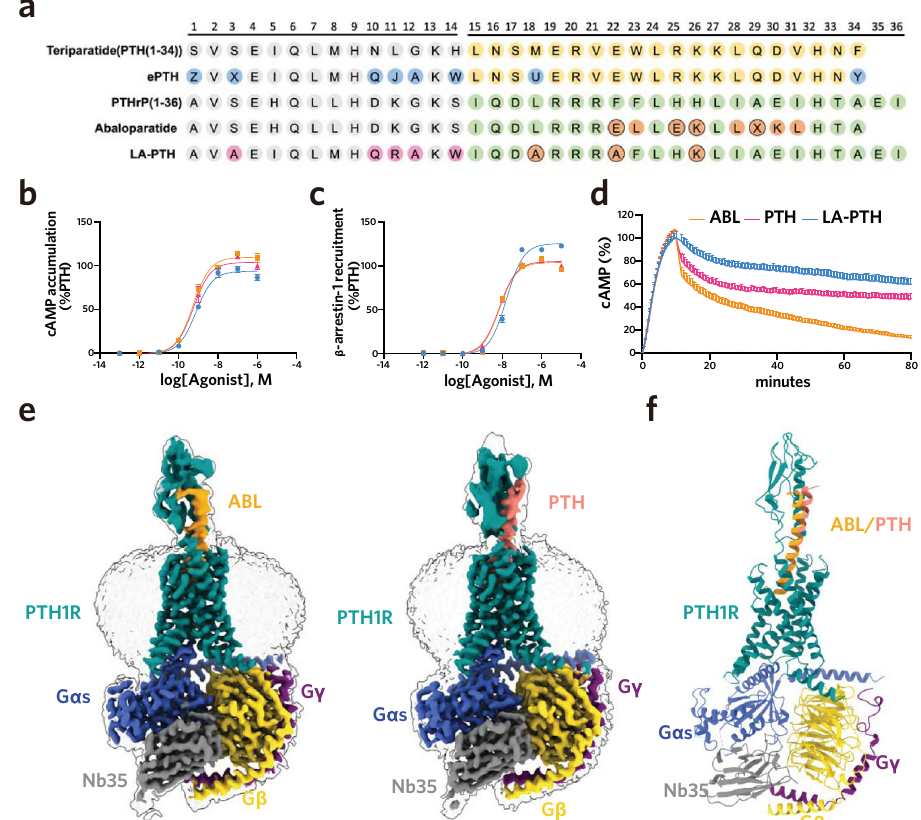
Fig. 1 | Cryo-EM structures of PTH – and ABL – bound PTH1R – Gs complexes. a Sequence alignment of the ligands assessed in this study. Relative to PTH, the amino acid substitutionsofePTHare colored blue andthe “ M ” substitutions of LA- PTHare colored pink.Relativeto PTHrP, theC-terminalsubstitutedresiduesofLA- PTH and ABL are colored orange. Amino acids are indicated in one-letter code, Z indicates Ac5c (aminocyclopentane-1carboxylic acid); X indicates Aib